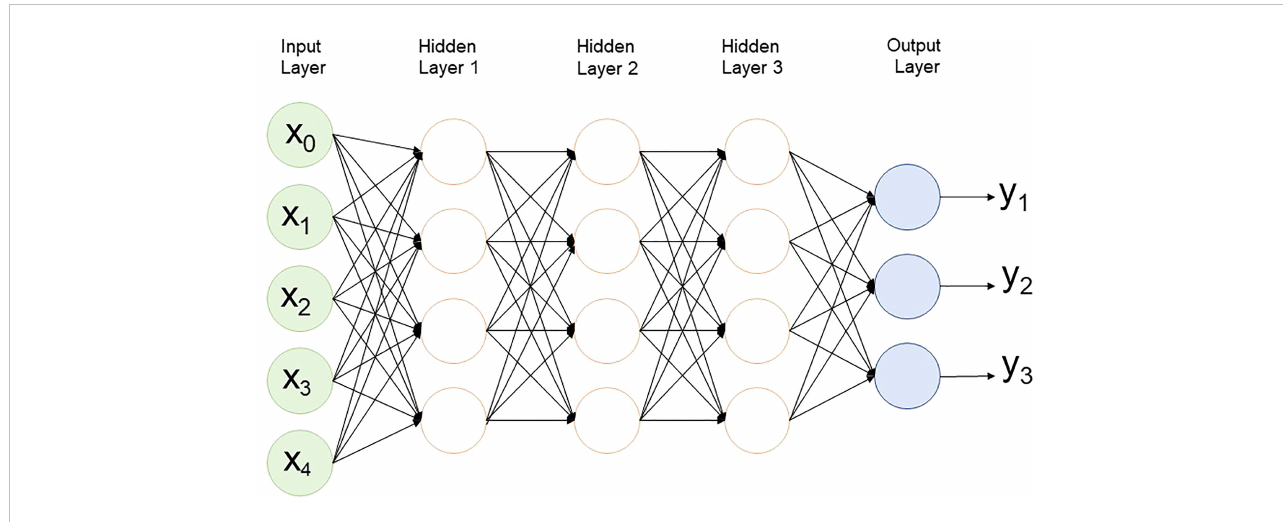
FIGURE 4 Multilayer perceptron structure with 3 hidden